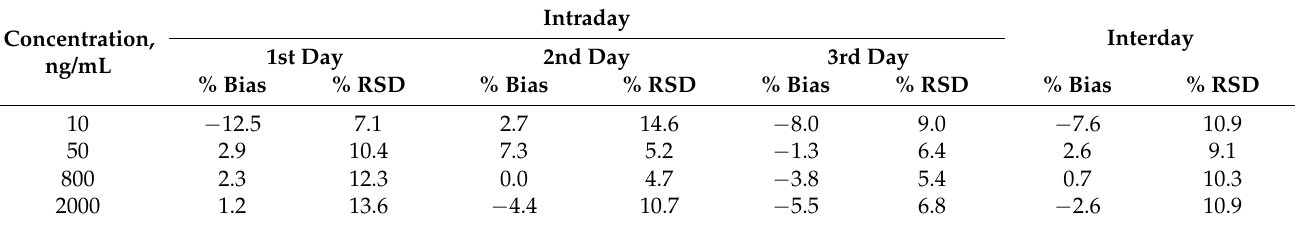
Table 1. Intraday and interday accuracy and precision.